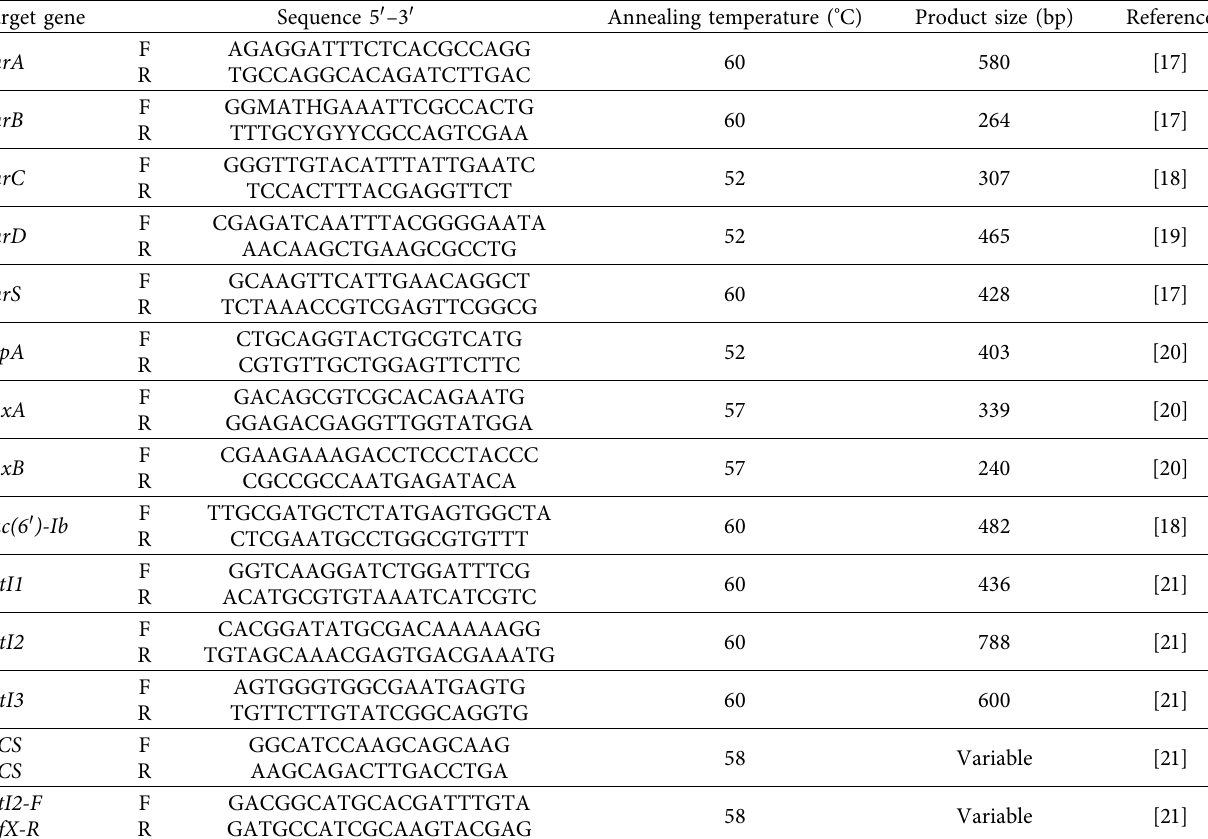
Table 1: Primer sequences and conditions used in PCR amplification.